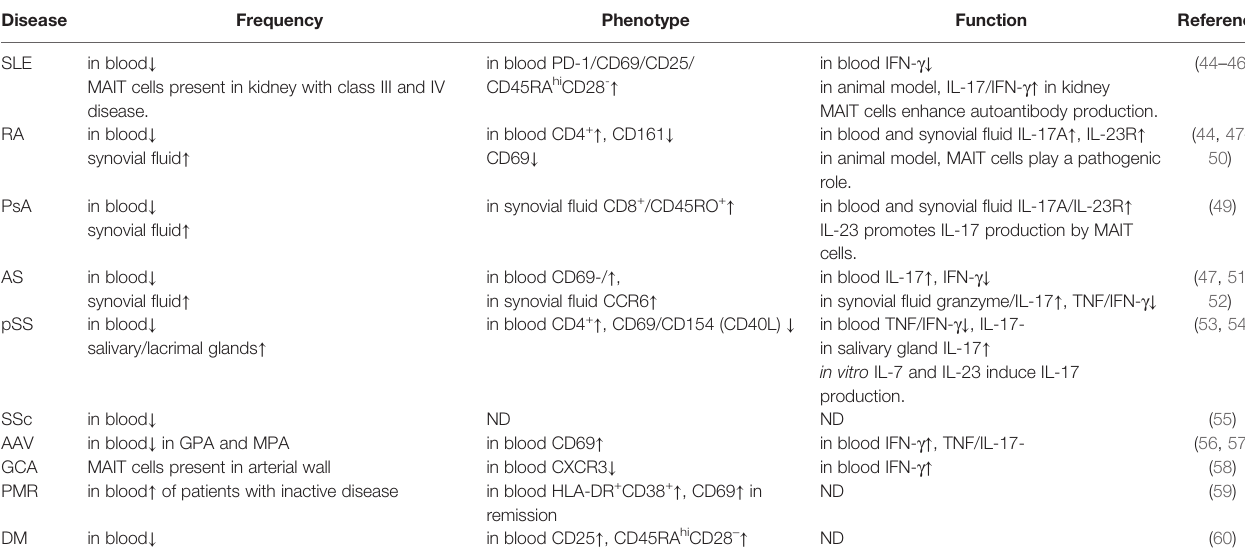
TABLE 1 | MAIT cells in rheumatic diseases.